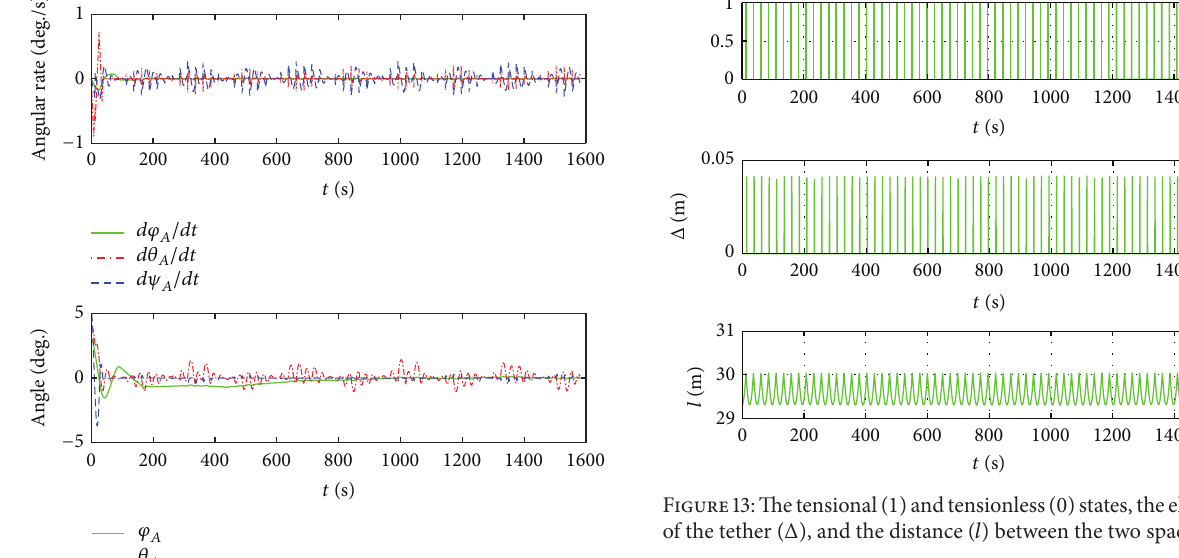
Figure 12: The angular rate and angle of the ROGER spacecraft.